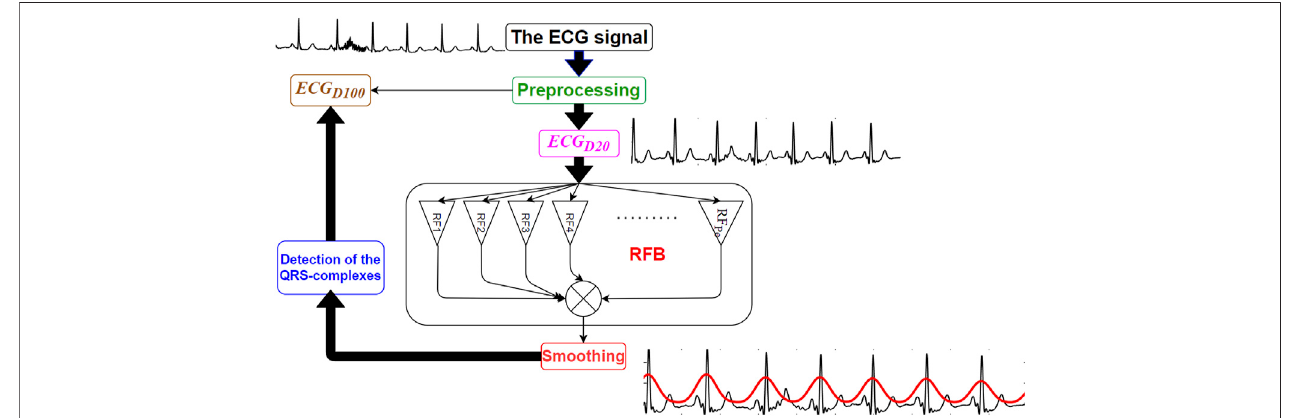
FIGURE 1 | Schematic diagram of the proposed RFB-based QRS-complex detection algorithm.